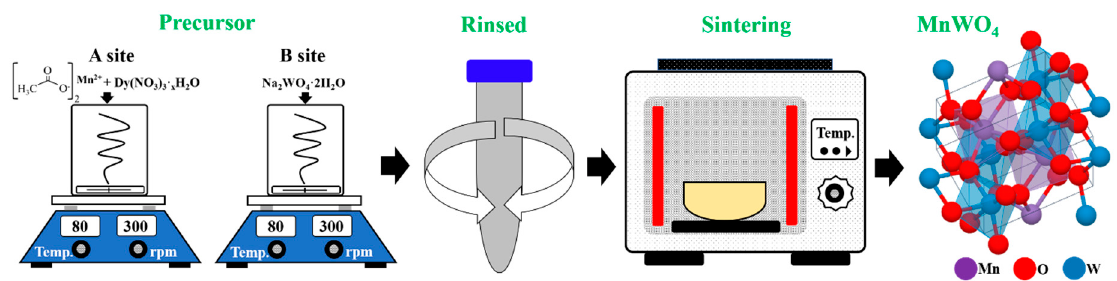
Figure 1. Schematic of MnWO 4 powder synthesis experimental procedure.